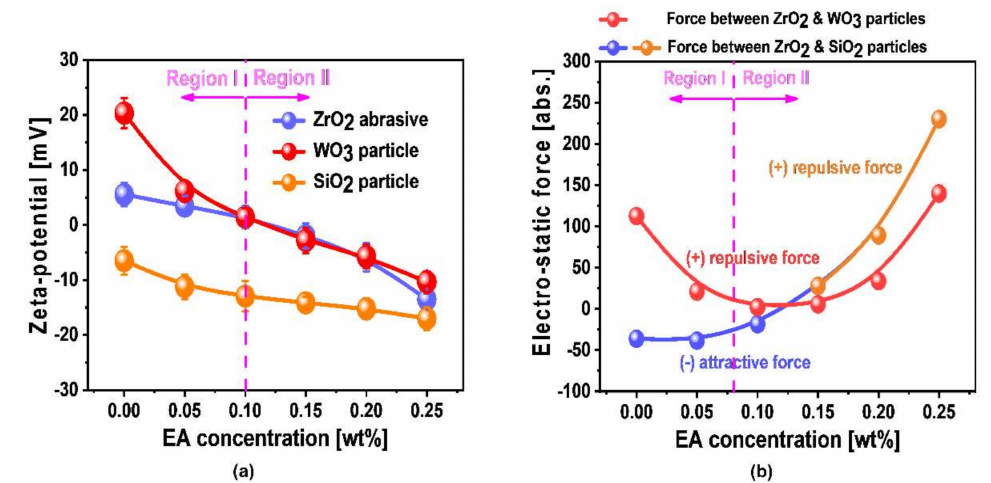
Figure 7. Dependencies of mechanical-dominant CMP properties on the scavenger concentration (i.e., EA). ( a ) Zeta potentials of ZrO 2 abrasives, WO 3 particles, and SiO 2 particles depending on the scavenger (i.e., EA) concentration, and ( b ) electrostatic forces between ZrO 2 abrasives and WO 3 particles as well as between ZrO 2 abrasives and SiO 2